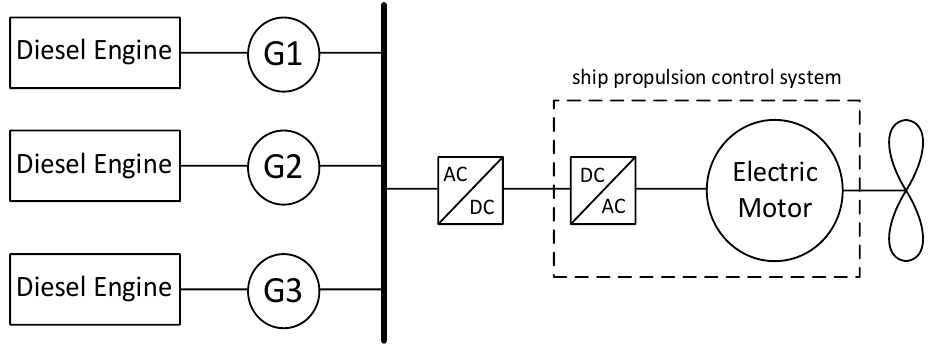
Figure 1. Traditionally used ship propulsion system in the diesel – electric system (AC grid).